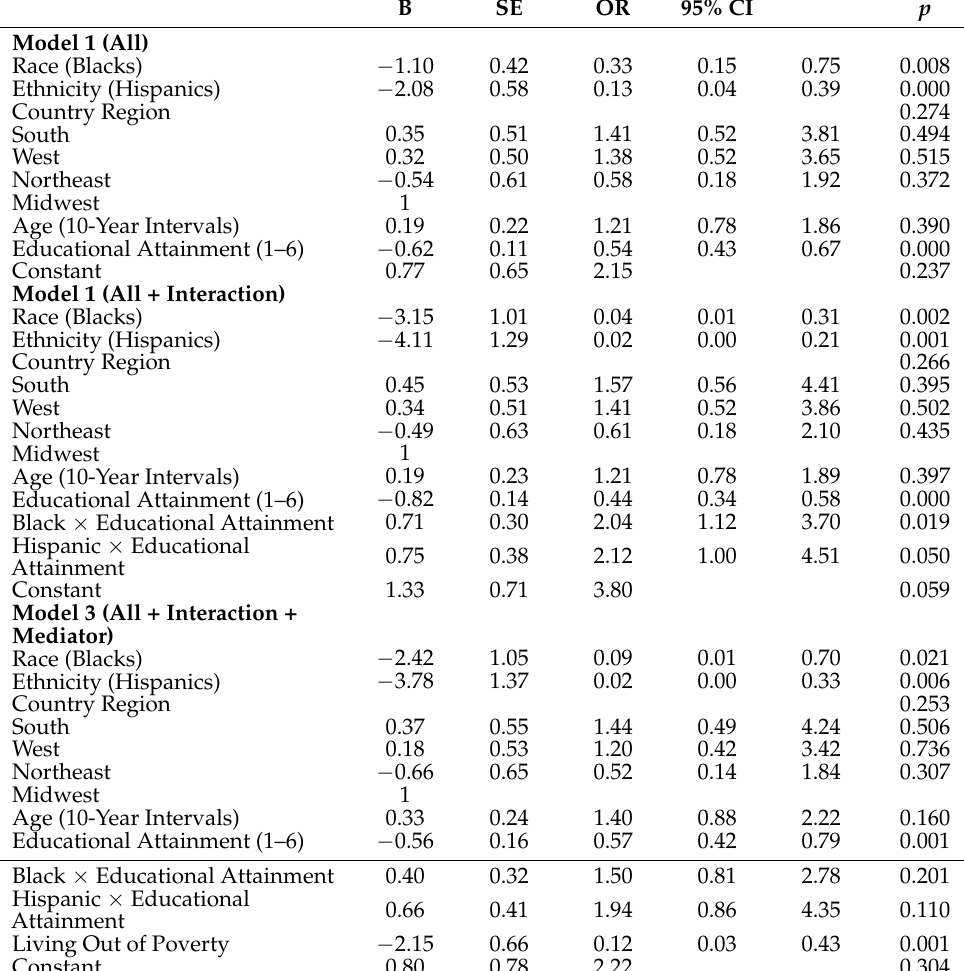
Table 2. Summary of three logistic regression on current smoking models in the pooled